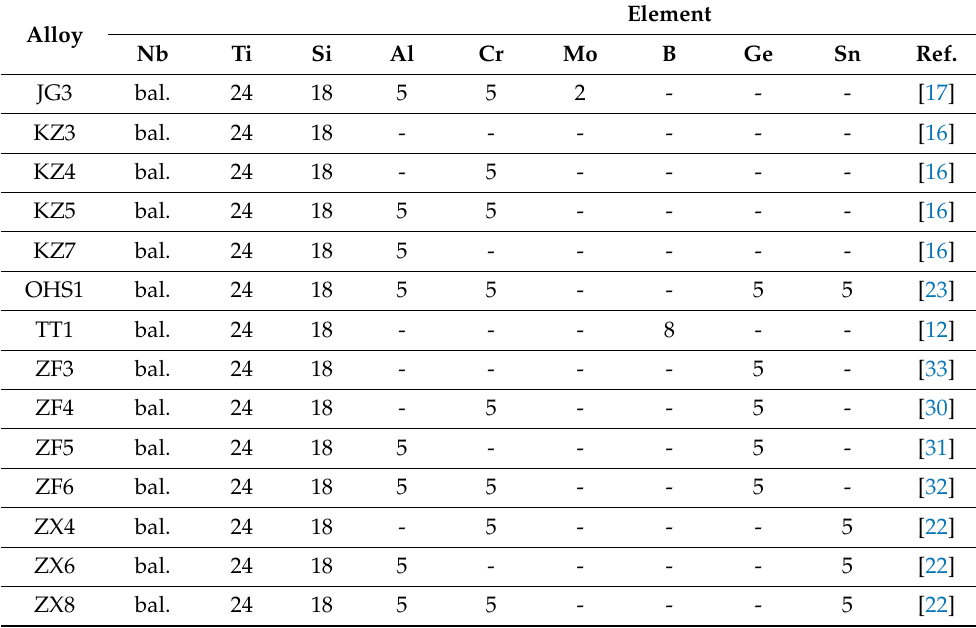
Table A1. Nominal compositions (at.%) of reference alloys used in this work.